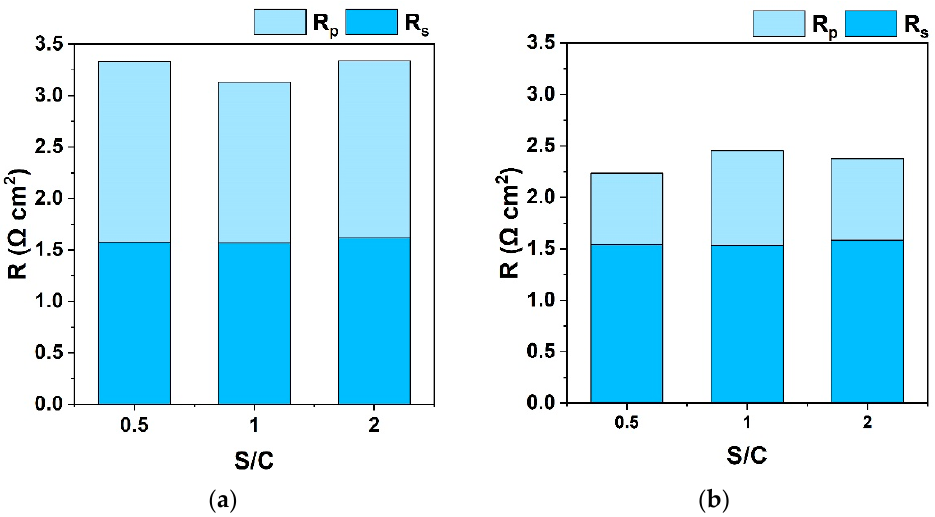
Figure 6. Ohmic (R s ) and polarization (R p ) resistance values obtained from fitting EIS data from Figure 5a,b that recorded under co-electrolysis at ( a ) 0 mA cm − 2 (open circuit) and ( b ) 250 mA cm − 2 for different H 2 O/CO 2 ratios in the fuel electrode feed in balance with He.